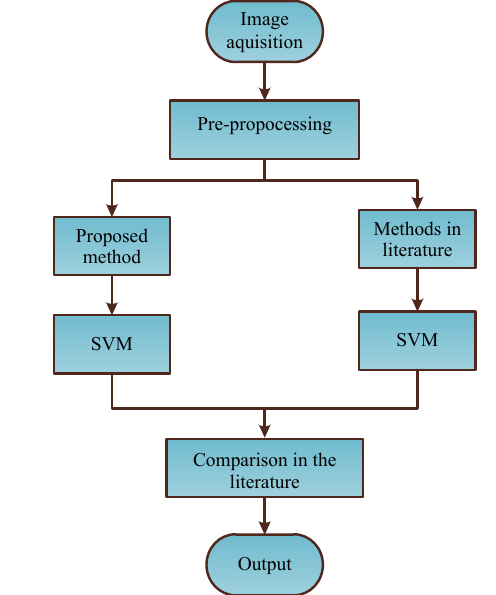
Figure 1. Framework of classification for 17 rice varieties. of neighboring points, and R is the radius of the